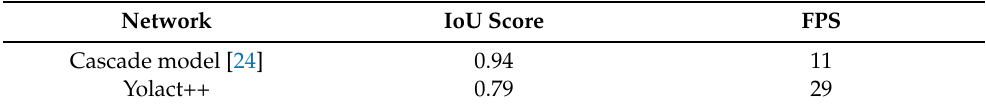
Table 4. IoU score and inference